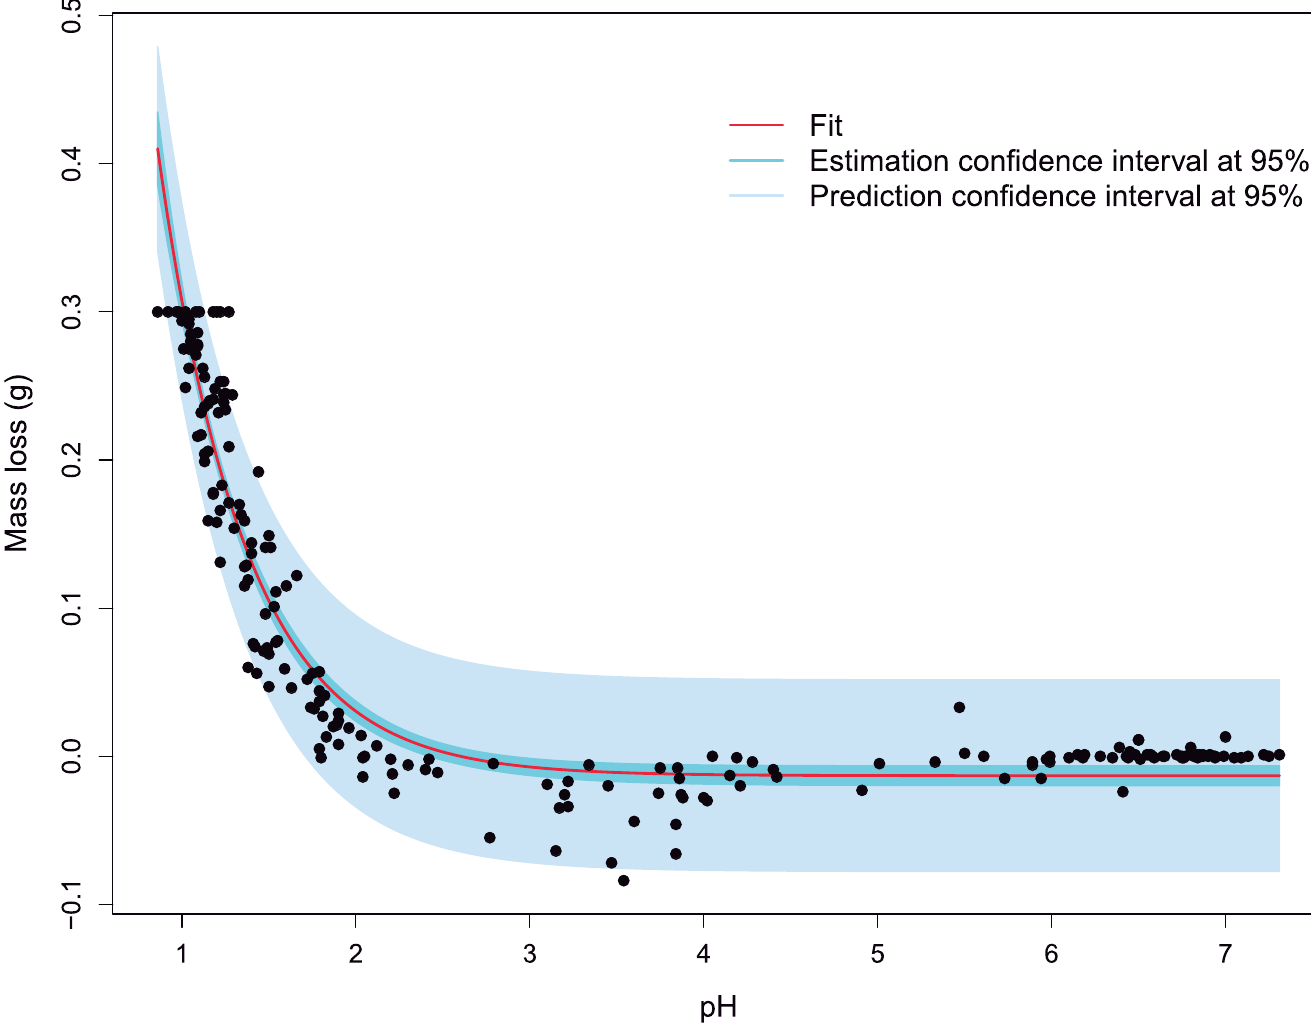
Fig 12. Asymptotic fixed effects regression model fitted mass loss vs. pH data. Fitted trend, real data, 95% estimation and prediction confidence intervals for conditional mean are included.